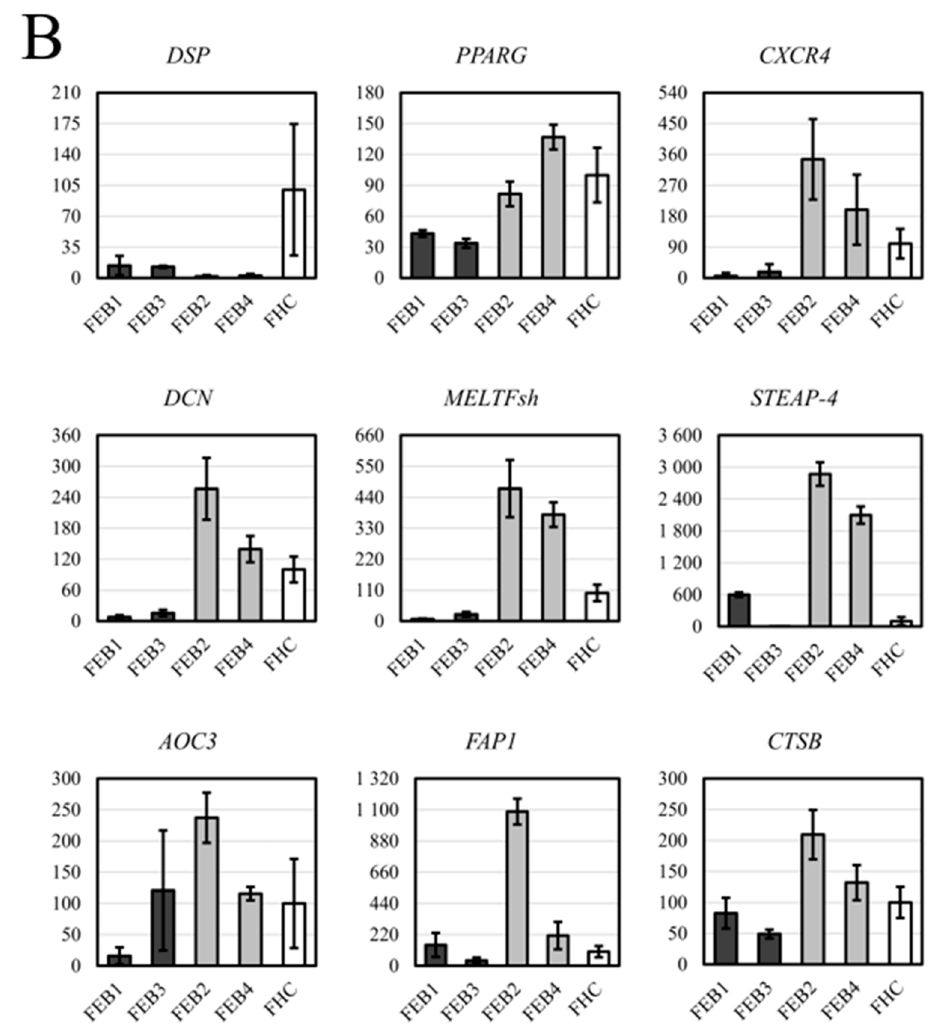
Figure 5. RT-qPCR analysis of DEG in FEB and FHC lines. Dark grey and light grey column colors indicate cell lines from patients with severe (FEB1, FEB3) and mild (FEB2, FEB4) forms of EB, respectively. White column color indicates the healthy control. The ordinate value is U—relative gene expression, estimated as ∆∆ CT, normalized to the mean of FHC. The mean of FHC was taken as 100%. The mean value and 95% confidence level is given for each FEB line and the average value of pooled data from several FHC lines. ( A ). Strong downregulation of IL1B, EREG genes was demonstrated, the upregulation of AGTR, PCOLCE-2,CTSZ were shown. ( B ). PPARG , CXCR4 , DCN , MELTF , IL7 and CTSB were increased in the milder group and decreased in the severe FEB group. DSP and TIMP3 were downregulated in all FEB lines, with a tendency to be further decreased in mild groups of FEB.